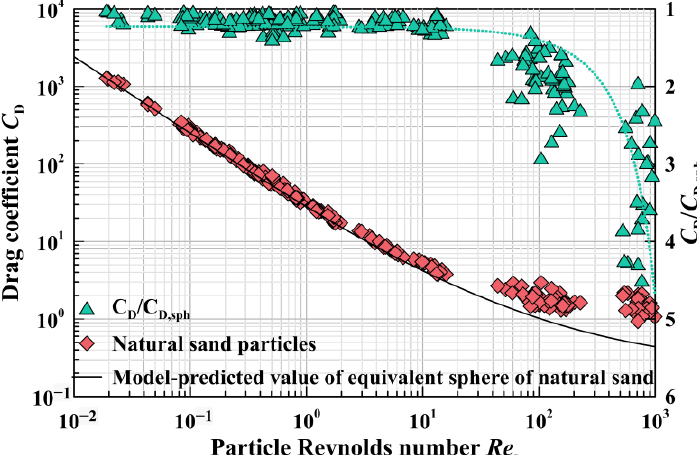
Figure 11. C D – Re s relationship obtained using 221 sets of irregular-shaped sand particle settlement experiments.